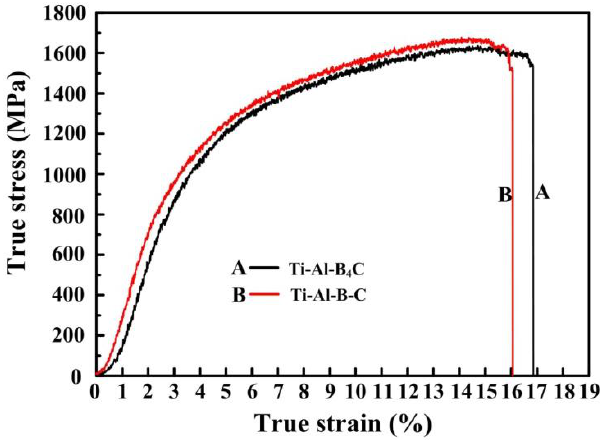
Figure 5. True compression stress-strain curves of the in situ dual reinforcement 6 vol. % TiB 2 -Ti 2 AlC/TiAl composites fabricated by using different